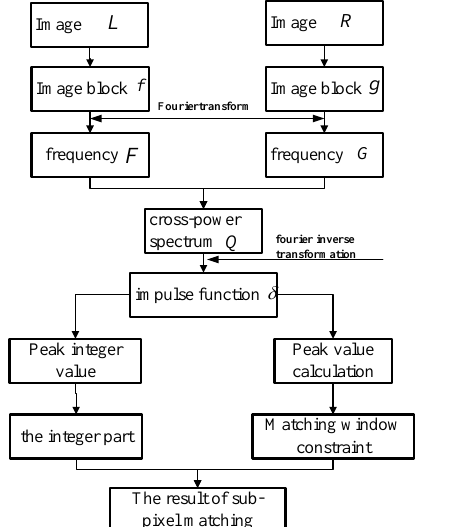
Figure 3 the process of phase correlation matching using peak calculation